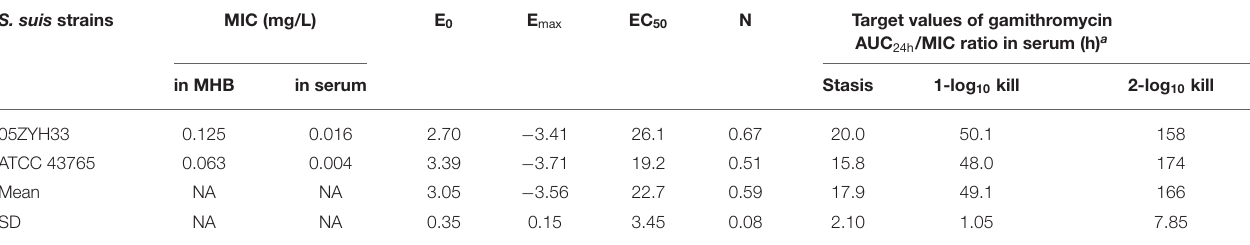
TABLE 2 | Pharmacokinetic/pharmacodynamic (PK/PD) target values of gamithromycin in serum (AUC 24h /MIC) needed to achieve the net stasis, 1-log 10 , and 2-log 10 kill endpoints for each S. suis strain tested a . S. suis strains